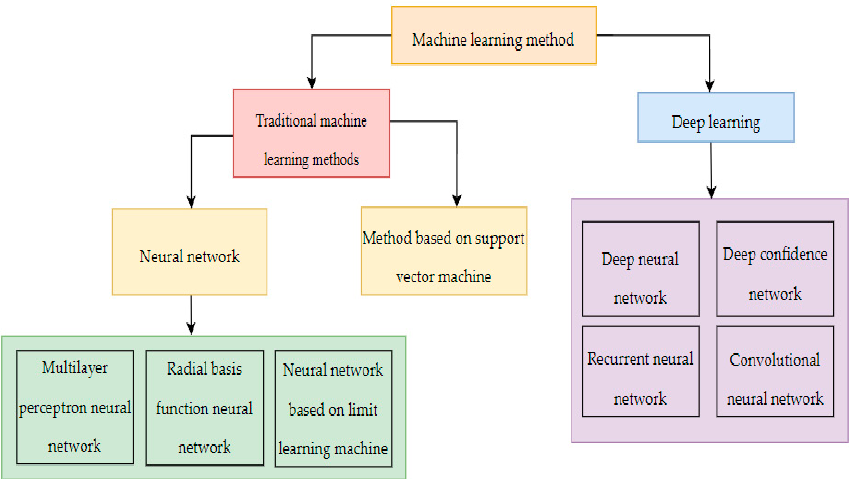
Figure 3. Classification of machine learning remaining life prediction